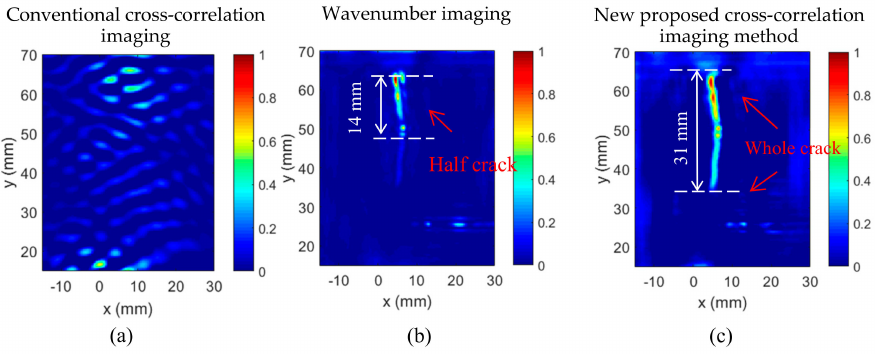
Figure 6. Imaging method comparison: ( a ) Original back-scattered cross-correlation imaging; ( b ) conventional wavenumber filtering imaging result of the hairline crack showing only half crack; and( c )theproposedcross-correlationimagingresultpresentingamoreaccurateimageoftheentirecrack.